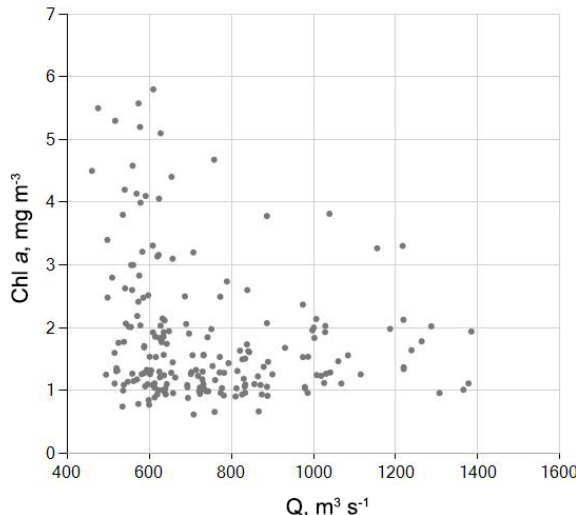
Figure 6. Dependence between the concentration of Chl a in the Kerch Strait and the adjacent area of the Black Sea retrieved from optical satellite imagery, on the one hand, and total discharge of the Don and Kuban rivers, on the other